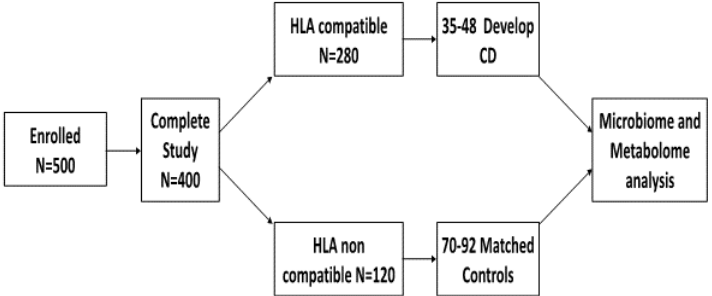
Figure 2. Study scheme outlining the recruitment and projected incidence of celiac disease (CD) and related HLA genotypes for participants in the Celiac Disease Genomic, Environmental, Microbiome, and Metabolomic Study.